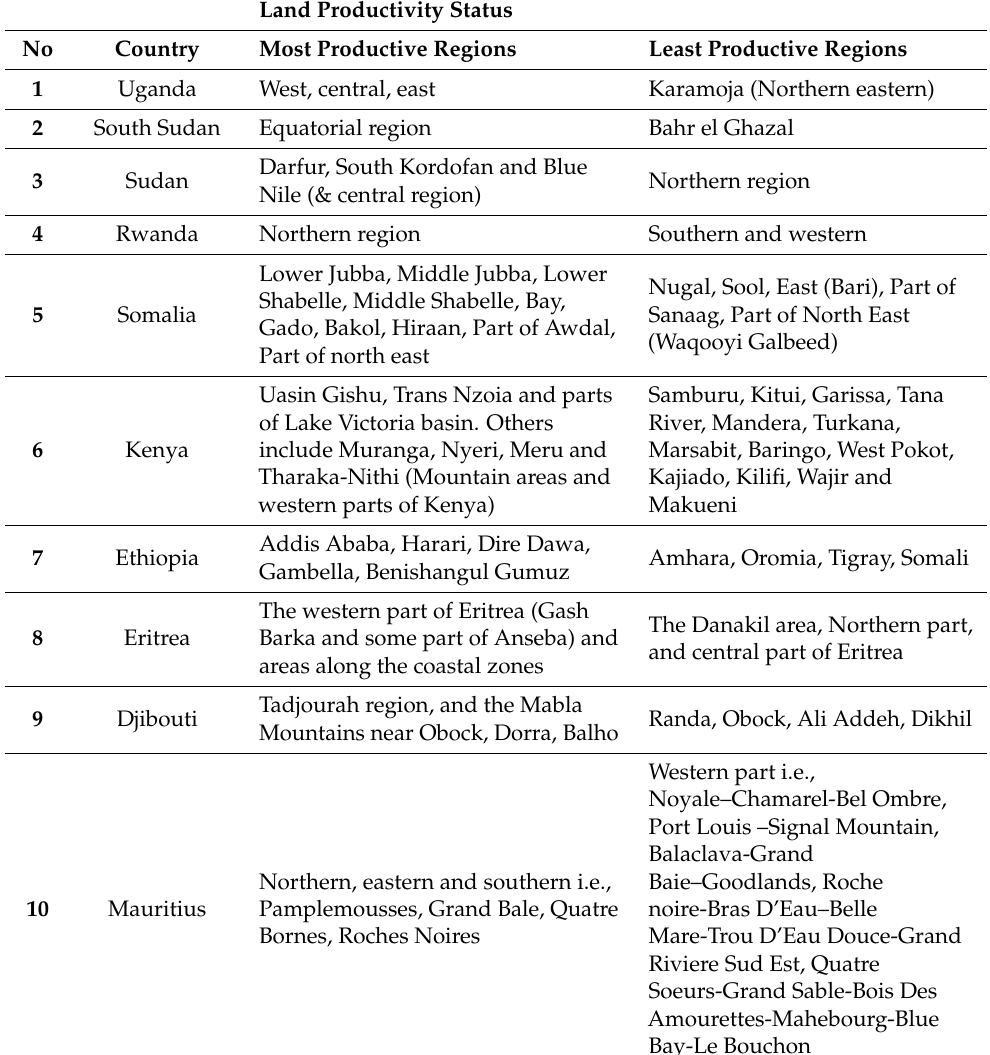
Table 17. Land productivity status in the studied countries. Land Productivity